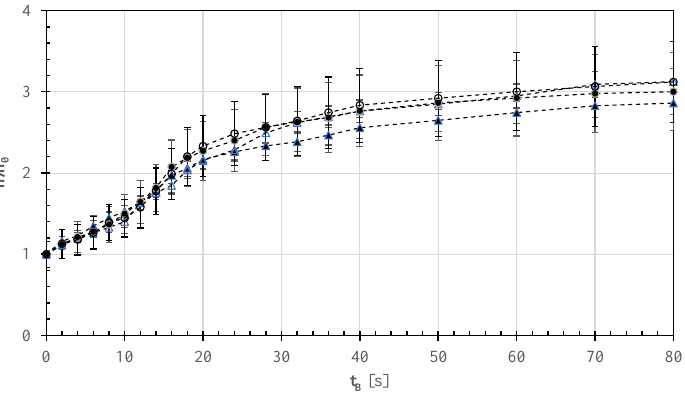
Figure 2. Effect of baking time (t B ) on the average value and standard deviation of the ratio between the instantaneous (h) and initial (h 0 ) heights of the raised rim of different pizza samples (A, (cid:78) ; B, (cid:52) ; C; ; D, ) during their baking in a pilot-scale wood-fired oven.